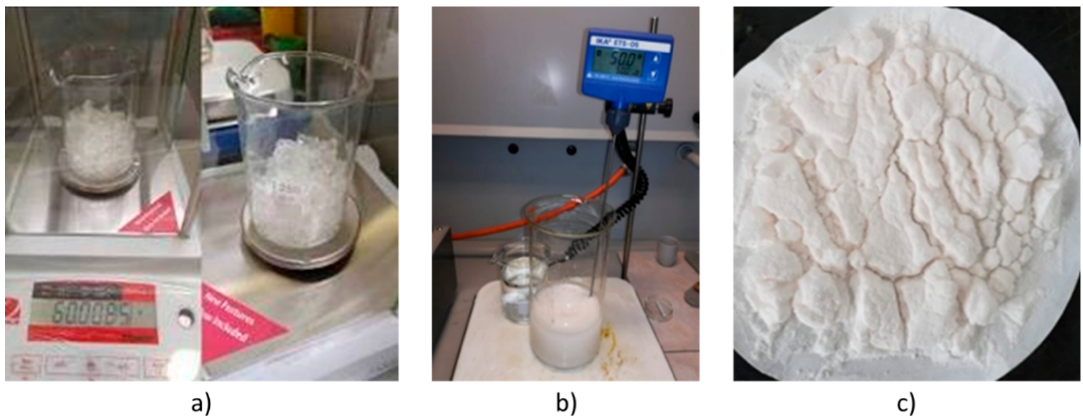
Figure 2. Synthetization process of PUF-DCPD microcapsules showing the ( a ) weighting of DCPD monomer at room temperature before phase transformation at 35 °C, ( b ) microcapsule formation at 50 °C, and ( c ) microcapsule suspension left to dry at room temperature for 24 h.